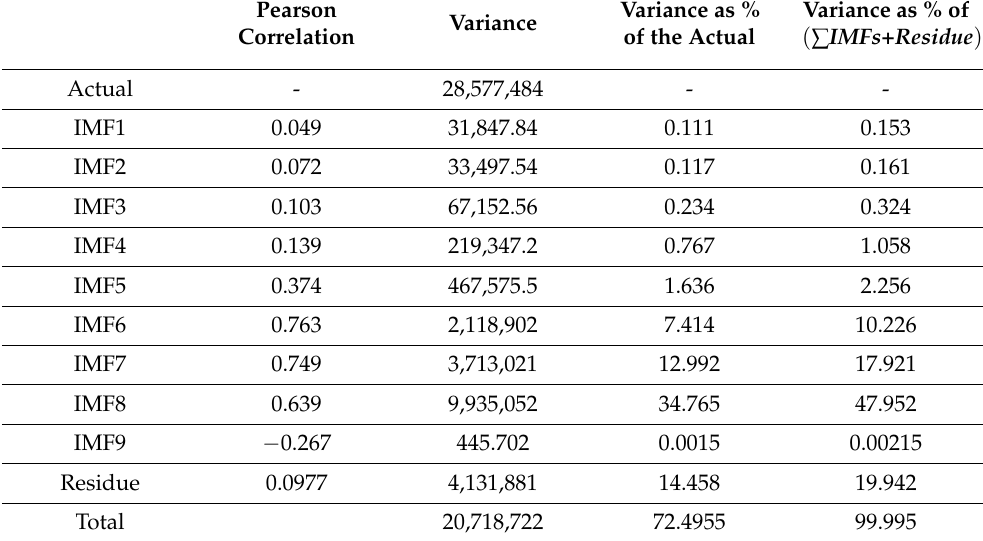
Table 4. Statistical measures of IMFs and residue extracted by implementing EEMD.